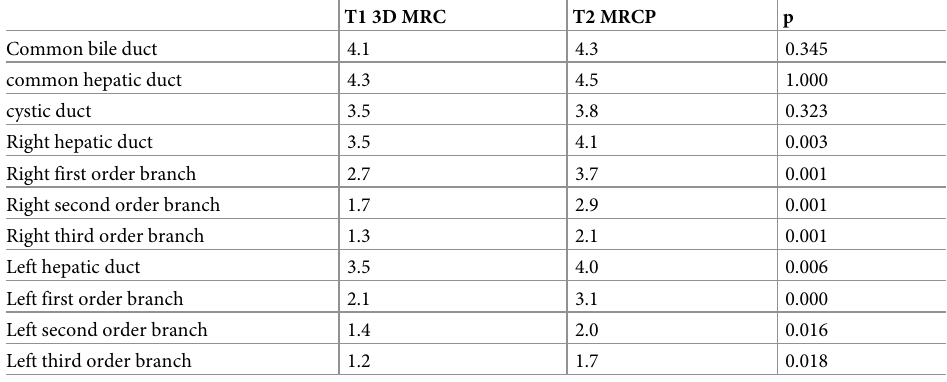
Table 2. Subjective evaluation of biliary duct